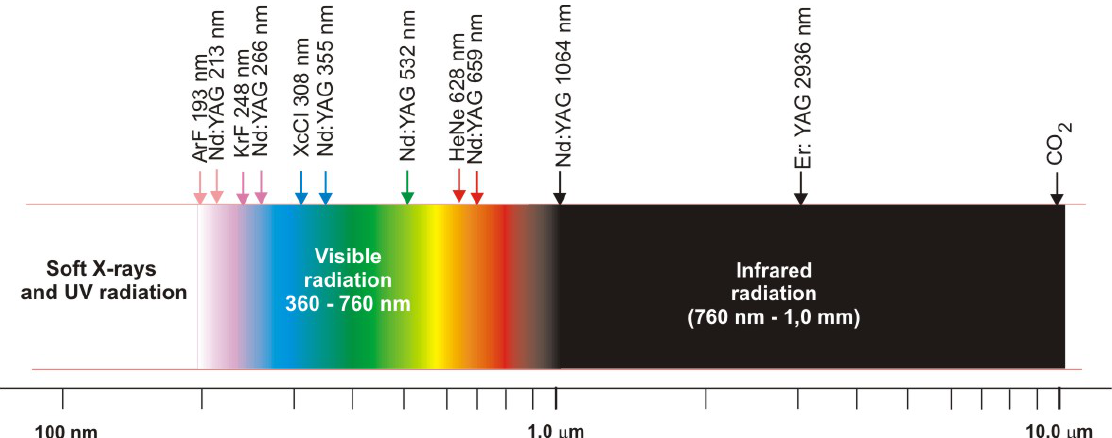
Figure 2. Most commonly lasers used in conservation of artworks. Location of laser wavelengths inside electromagnetic radiation